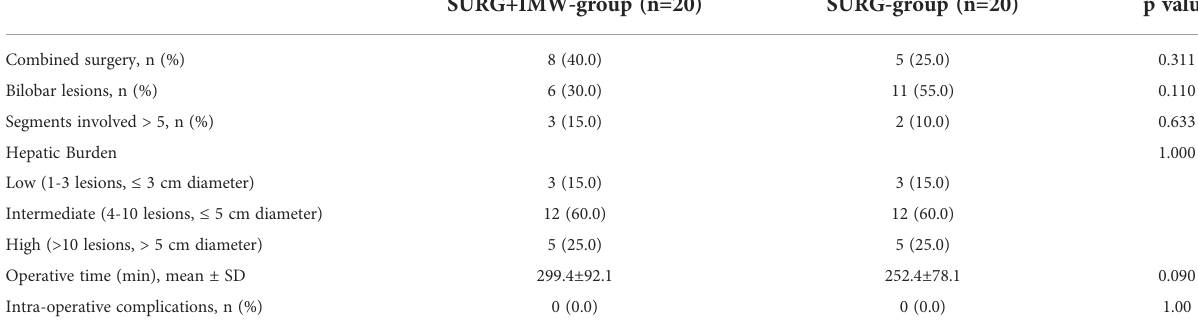
TABLE 2 Intra-operative